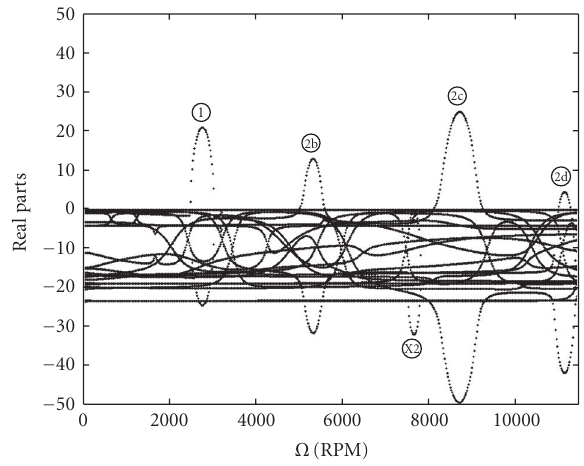
(cid:2) 2 in the complex plane diagram.